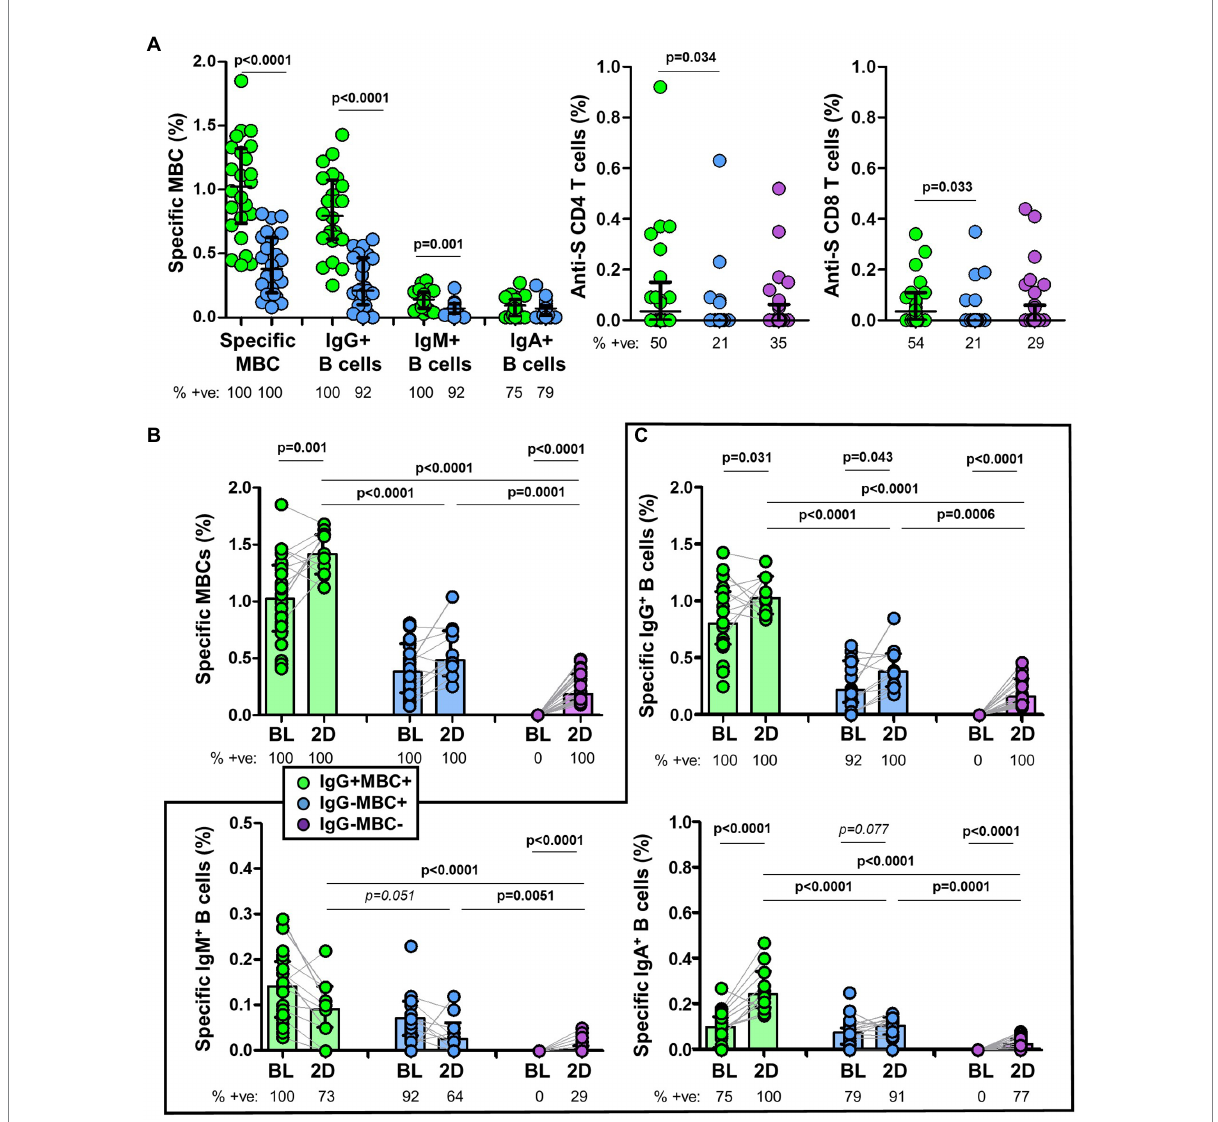
FIGURE 3 (A) Frequency of specific memory B cells (MBCs) and isotypes in IgG + MBC + (green) and IgG − MBC + (blue) groups, and anti-S CD4 + and CD8 + T cells in IgG + MBC + (green), IgG − MBC + (blue), and IgG − MBC − (purple) groups after two doses of vaccine. (B) Frequency of specific MBCs after two doses of vaccine compared to baseline in IgG + MBC + (green), IgG − MBC + (blue), and IgG − MBC − (purple) groups. (C) Frequency of isotype IgG, IgA and IgM memory B cells after two doses of vaccine compared to baseline in IgG + MBC + (green), IgG − MBC + (blue), and IgG − MBC − (purple) groups. Mann– Whitney test. Only significant differences are shown. Statistically significant when p <